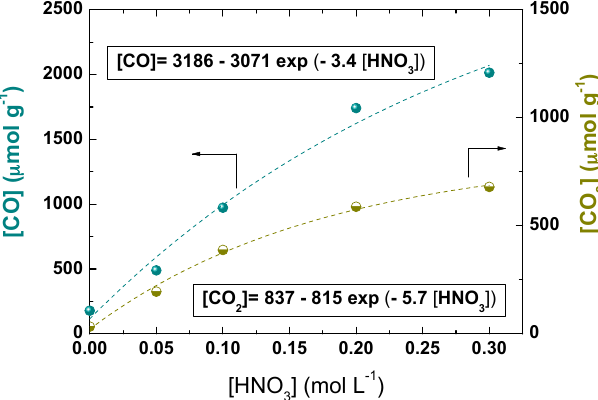
Figure 3. Evolution of the amounts of CO and CO 2 released from the surface of the hydrothermally treated CNTs (at 473 K) with HNO 3 concentration (adapted from [32]).